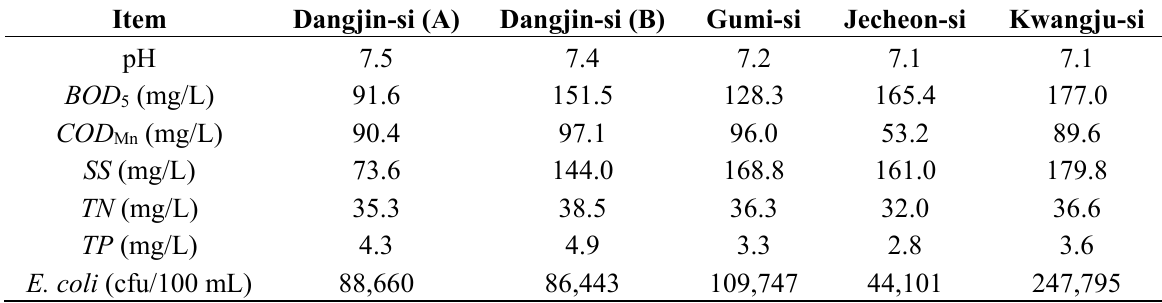
Table 2. Characteristics of wastewater for the field-scale DMBR TM systems.